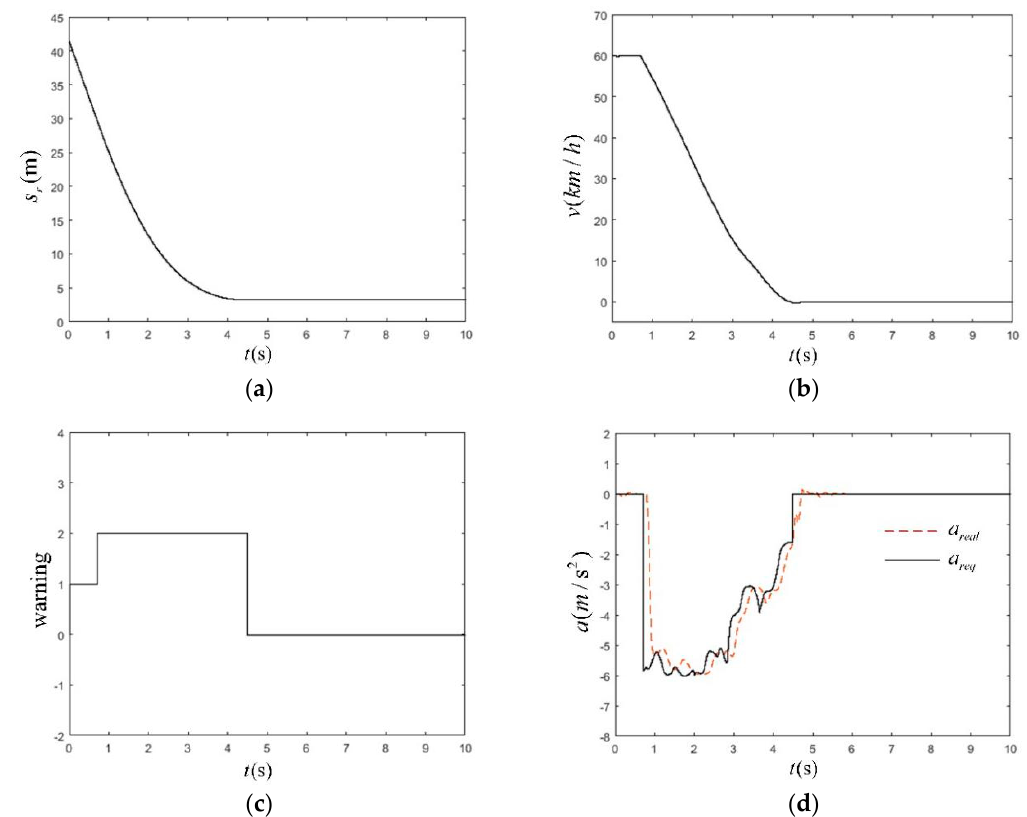
Figure 27. The simulation time as a function of station ( a ), velocity ( b ), warning signal ( c ), deceleration